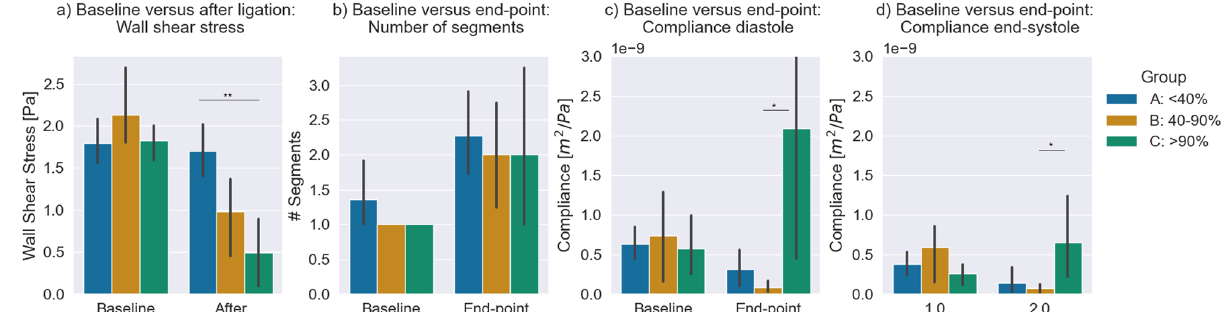
Figure 6. Quantitative comparisons at specific time-points. ( a ) The wall shear stress at baseline and first follow-up measurement ( b ) The number of detected segments at baseline and last measurement ( c ) The compliance at diastole at baseline and last measurement ( d ) the compliance at end-systole at baseline and last measurement. The 95% confidence interval is indicated by the black bar. Unpaired t test was performed between groups to quantify significance. (*<0.05, **<0.01 and ***< 0.001).